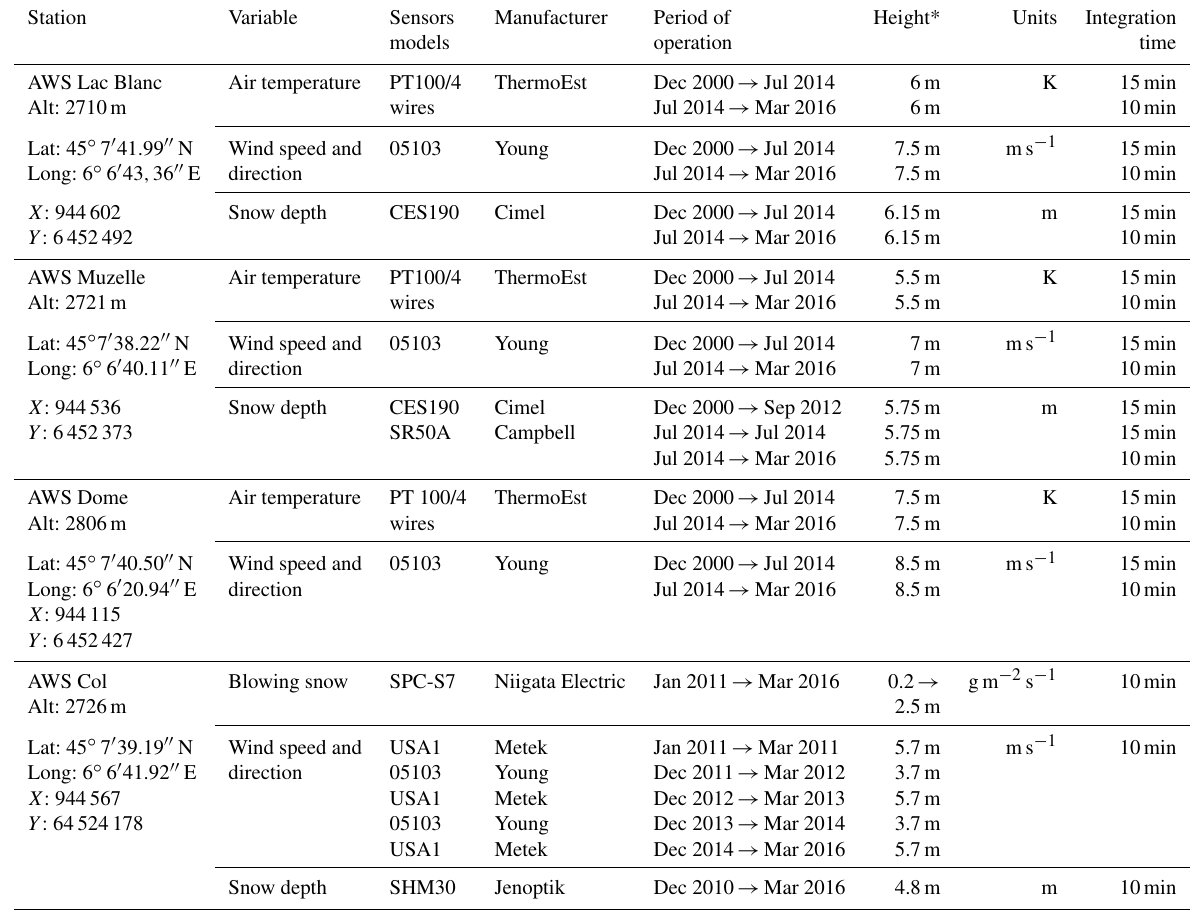
SHM30 Jenoptik Dec 2010 → Mar